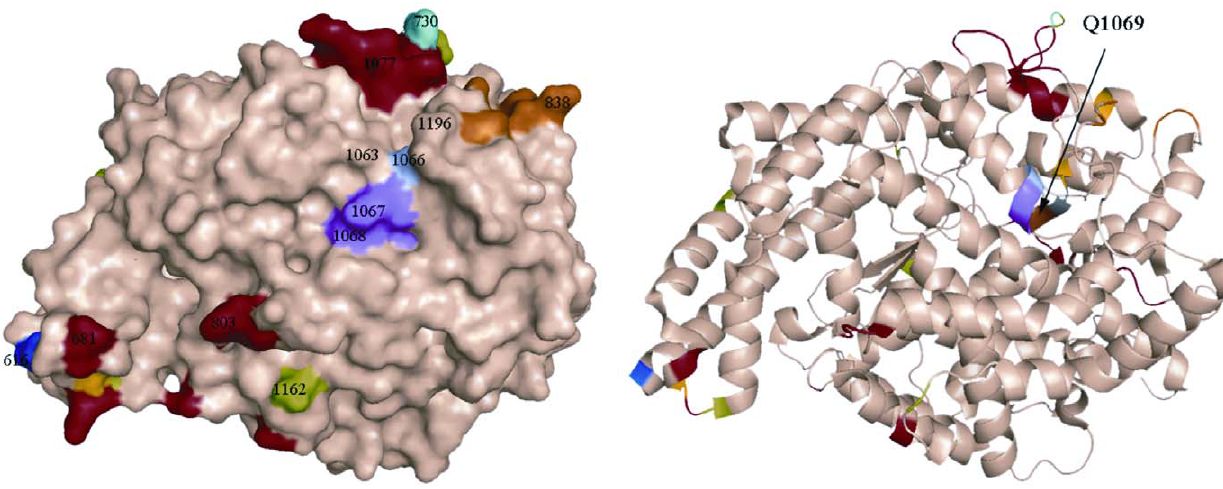
Figure 2. Localization of new mutation (Q1069R) in the C domain of somatic ACE. The localization of Gln1069 in the C-domain of human ACE which was mutated to Arg is shown using molecular surface ( A ) and ribbon ( B ) representations of the substrate-bound crystal structure of the C- domain fragment of human ACE, where the 36 amino acid residues unique to tACE were deleted [75]. The surface and ribbon are light brown, and amino acid residues that were crucial for orientation are colored. Key amino acids referred to in the text are denoted using somatic ACE numbering. Gln1069 (brown) is located right under the bump created by Lys1067 and Tyr1068 (purple) and shown by arrow. Dark blue indicates the first N- terminal amino acid residue (Asp616) seen in this structure; orange-indicates the C terminal end of the C-domain (and the epitope for mAb 1B3; [16,36]. Light blue (P730) and red colored amino acid residues indicate highly immunogenic bumps on the surface of the C-domain. Light green indicates Asp in putative glycosylation sites.